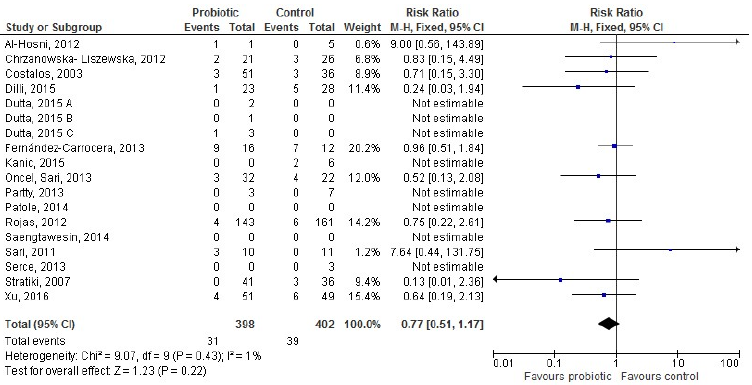
Figure 4. The forest plot shows the association between the use of probiotics and late onset sepsis in the sixteen studies reporting data for exclusively formula-fed preterm infants. M–H: Mantel–Haenszel method.